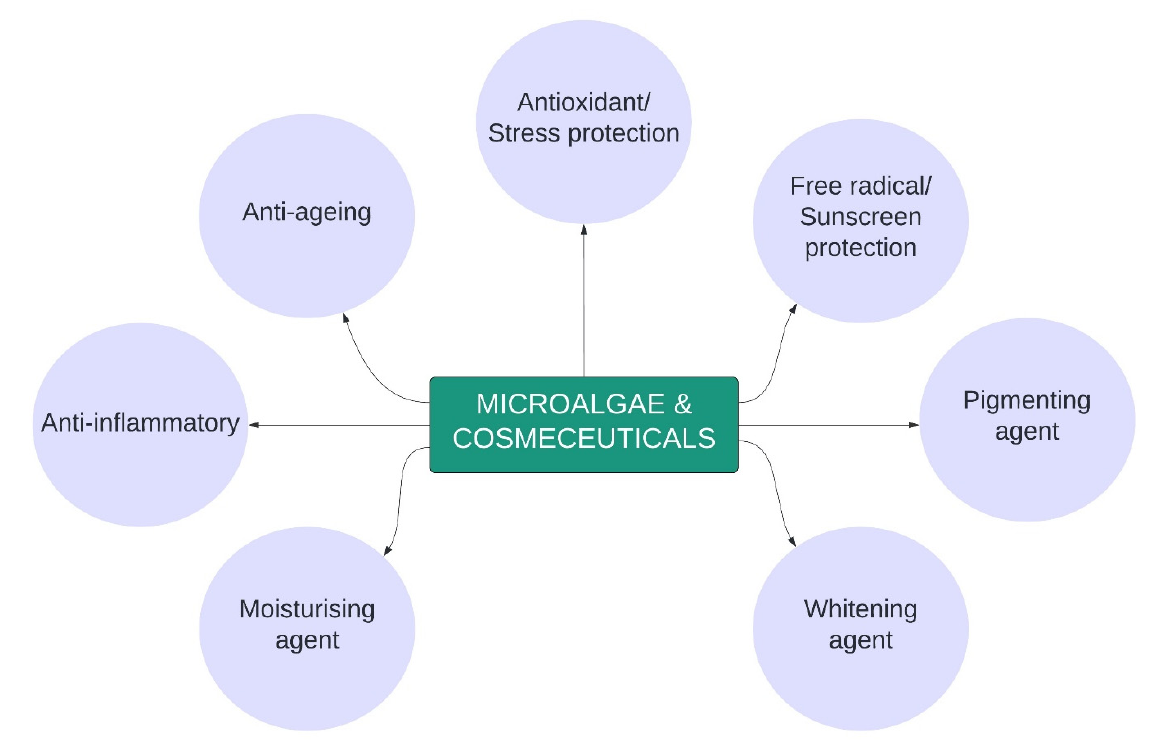
Figure 5. Potential applications of microalgae in cosmeceuticals.